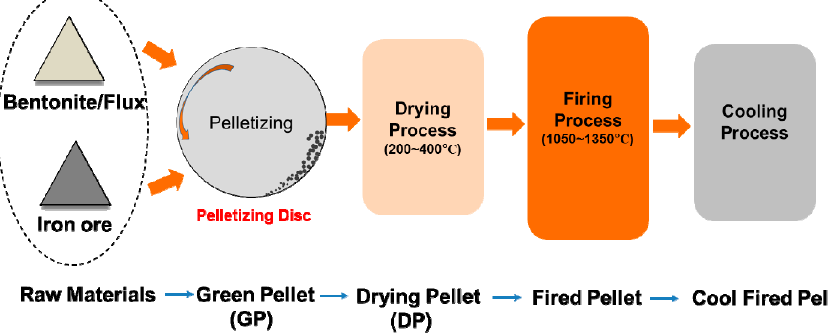
Figure 1. Schematic diagram of the pelletizing process.